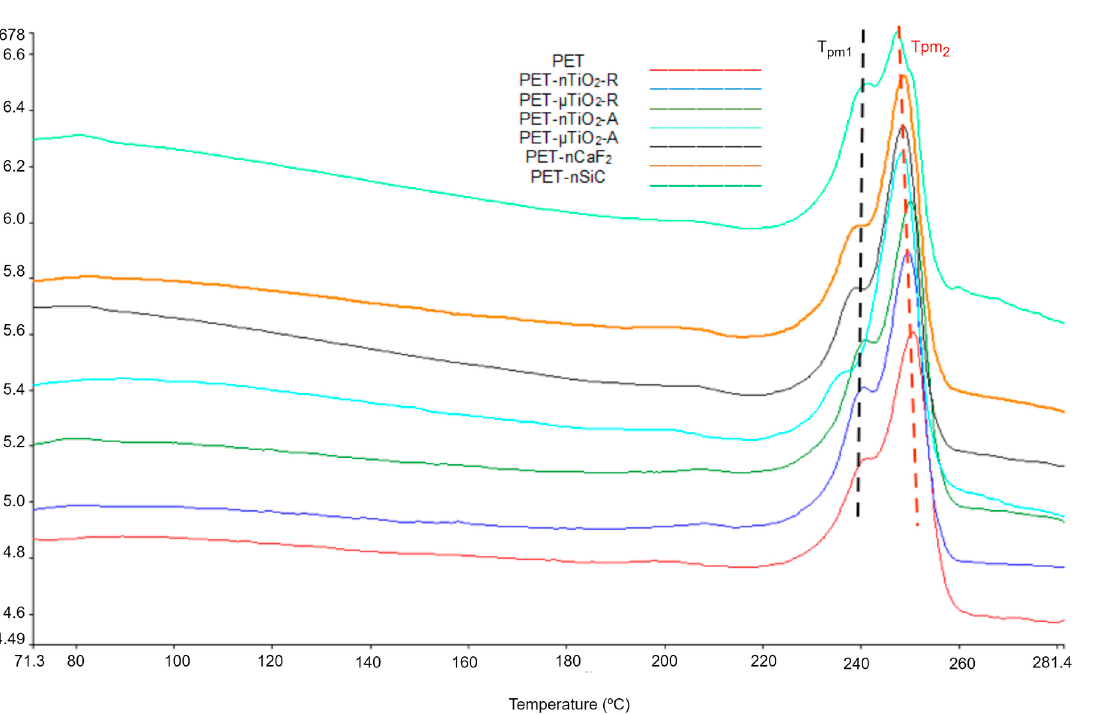
Figure 7. ( a ) Crystallinity of yarns (1st heating) and ( b ) Crystallization peak of yarns as a function of the exposure time.